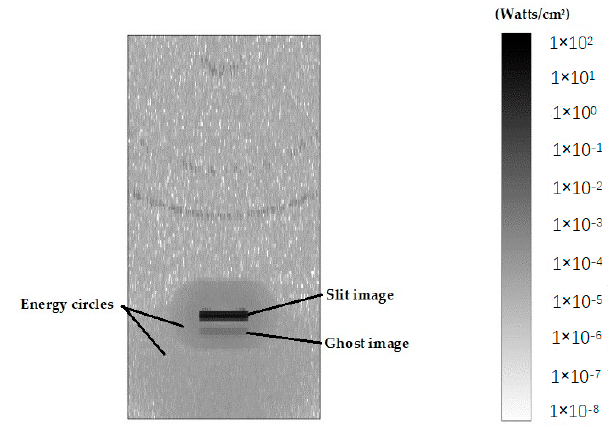
Figure 3. Incoherent radiation of slit image.